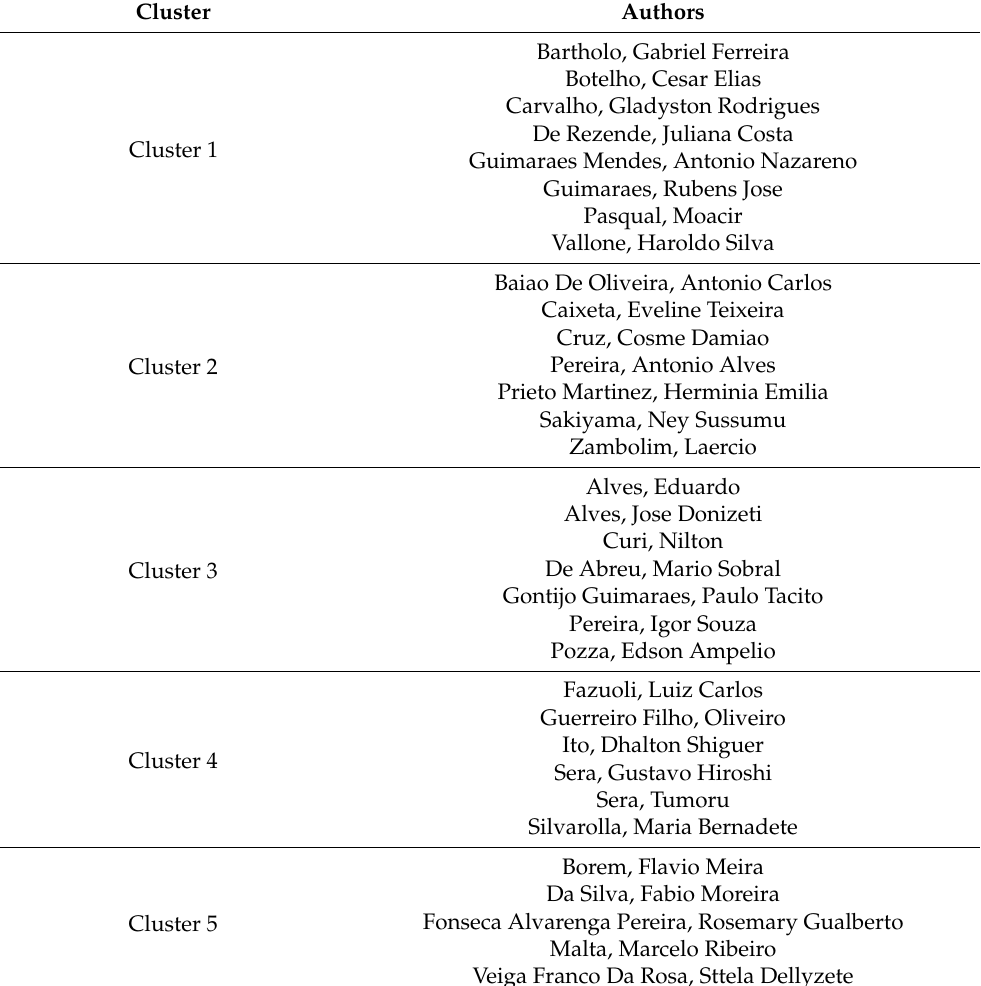
Table A2. Cluster of prolific coauthors